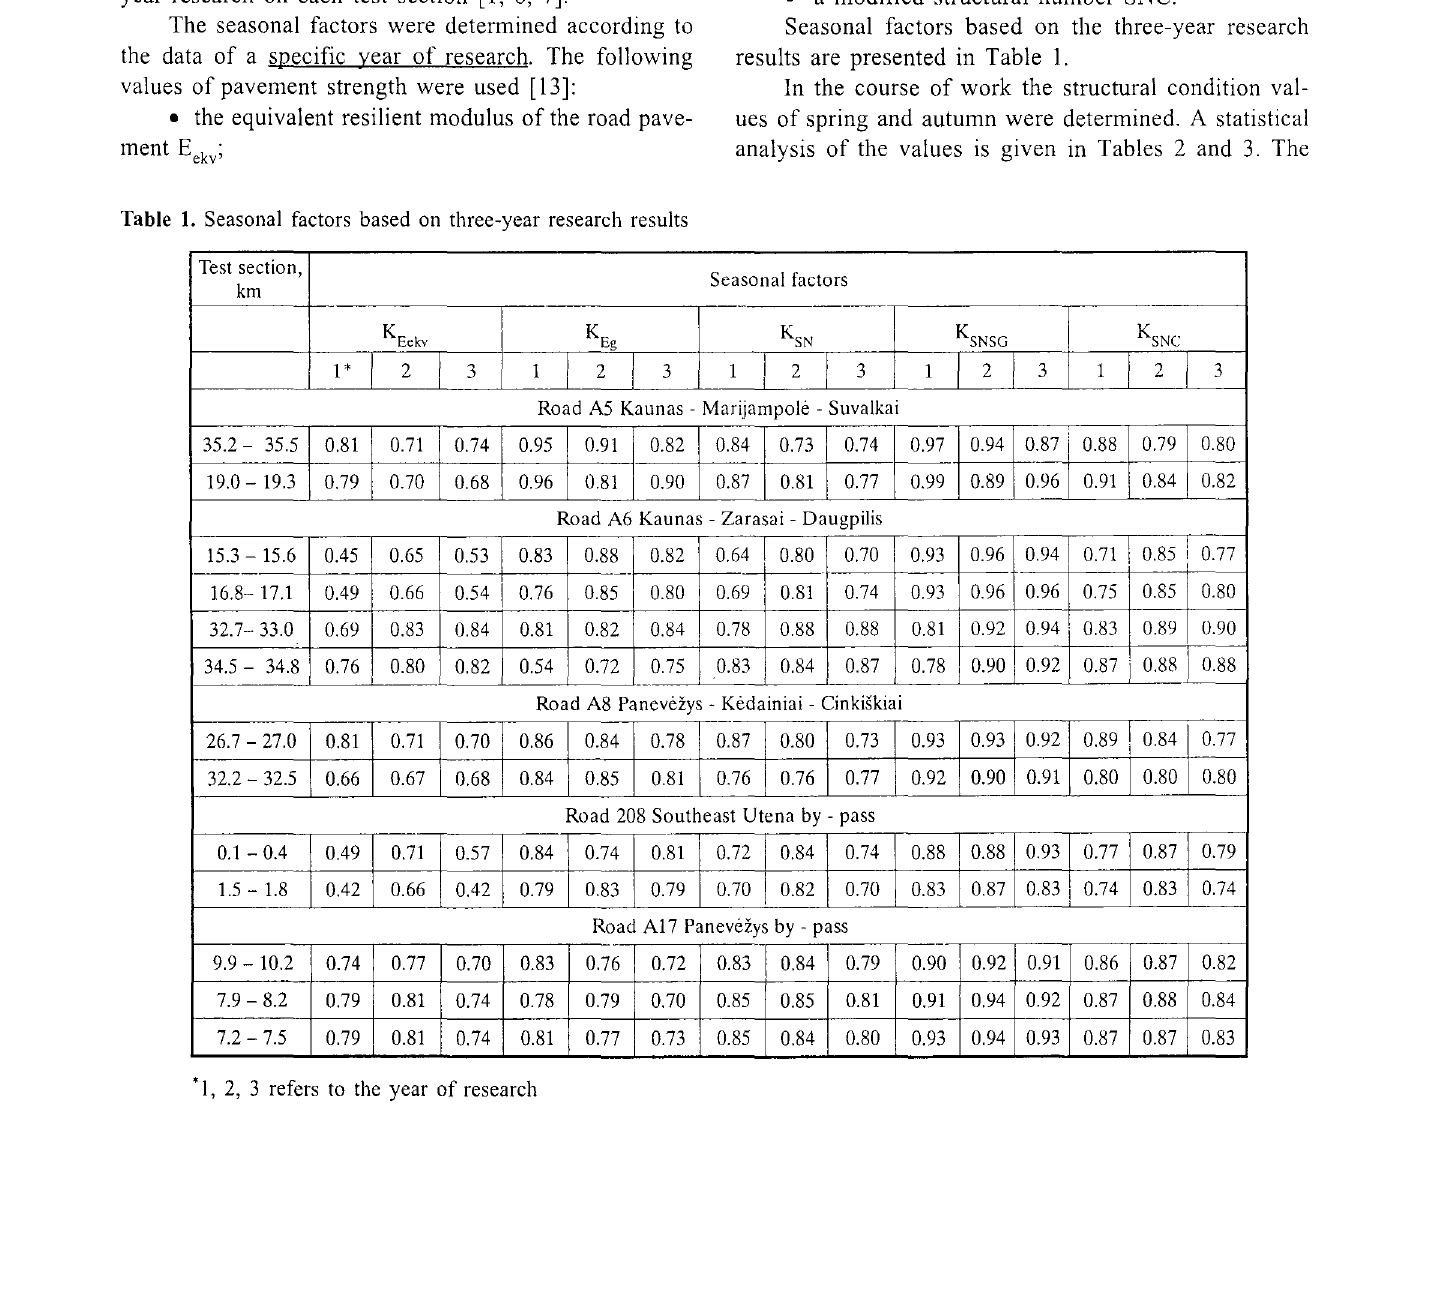
Fig 2. The scheme of the seasonal factor